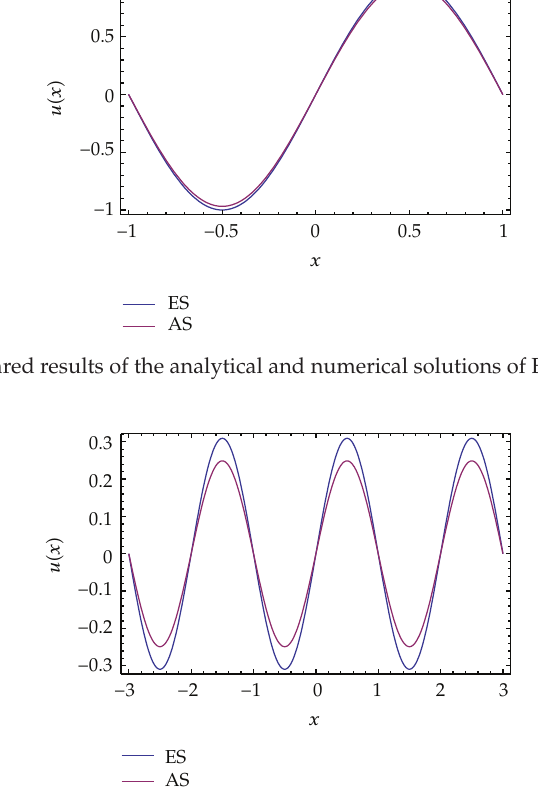
Figure 2: The compared results of the analytical and numerical solutions of Example 4.1 for t (cid:3) 1 . 0.